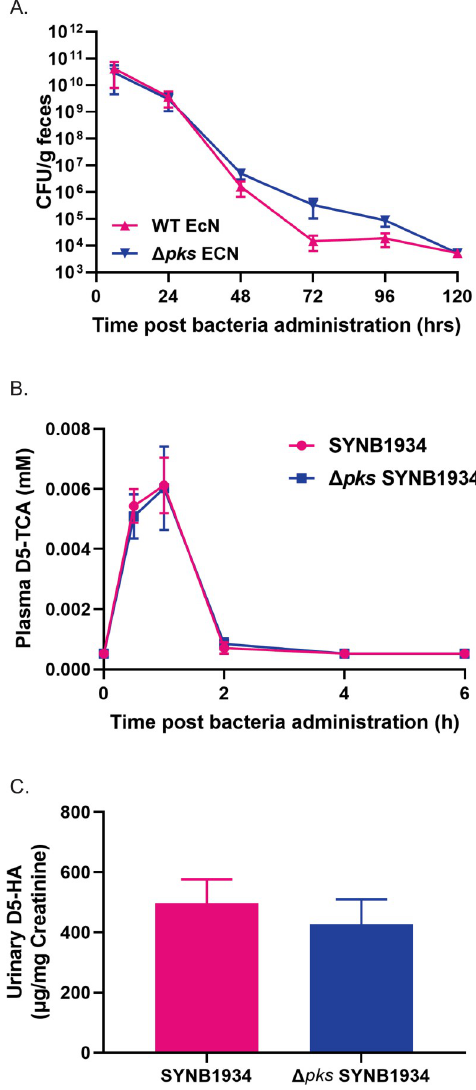
Fig 6. Kinetics and activity of WT EcN and Δ pks EcN in nonhuman primates (NHPs). (A) Fecal excretion of EcN strains in NHPs (n = 6 per group) following oral administration of a combined dose (1x10 12 CFU of each bacterial strain) of WT EcN (pink) or Δ pks EcN (dark blue) over 120h, (LLOQ = 1.5x10 2 CFU/g feces). Data are presented as mean ± SEM. Statistical analysis was performed using 2-way repeated ANOVA followed by Sidak’s multiple comparison test (p > 0.05). (B) Appearance of plasma D5-TCA (B) and urinary recovery of D5-HA (C) in NHPs (n = 12 per group) following oral administration of a single dose (1x10 12 CFU) of SYNB1934 (pink) or Δ pks SYNB1934 (dark blue). Data are presented as mean ± SEM. Statistical analysis was performed using 2-way repeated ANOVA followed by Sidak’s multiple comparison test (B) and unpaired t-test with Welch’s correction (C).